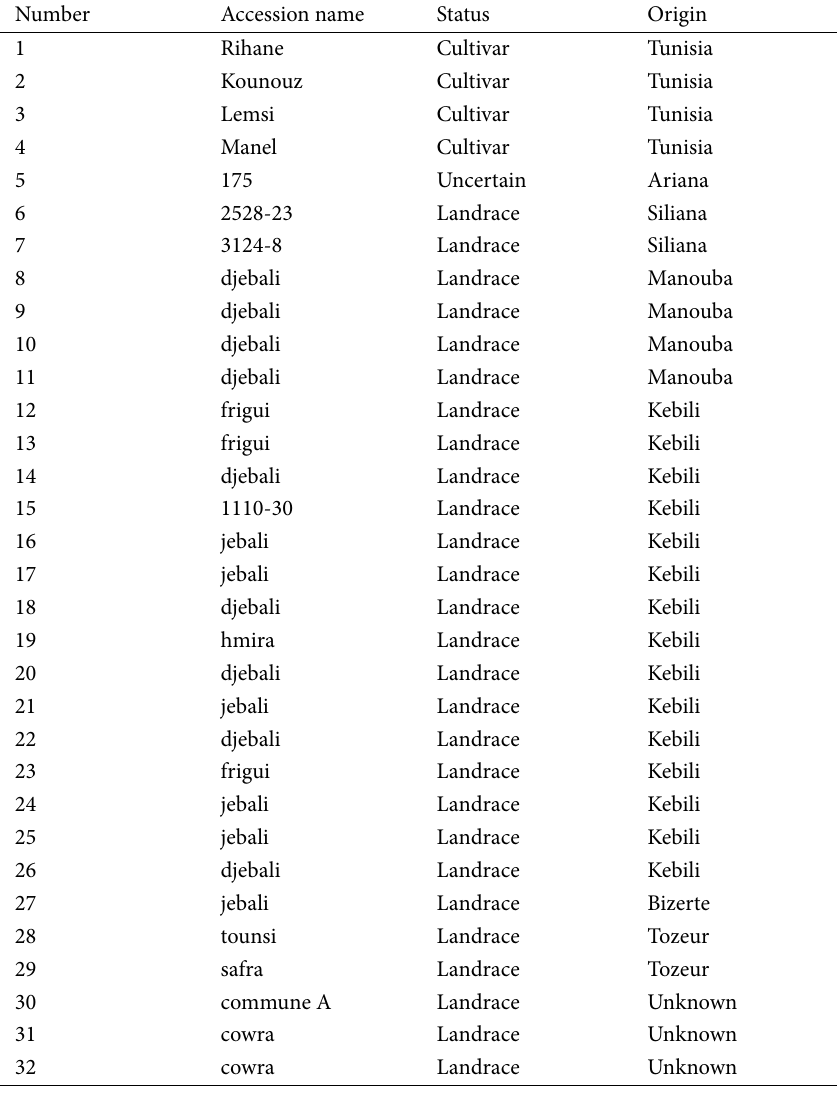
Table 1 List of 32 Tunisian barley lines used for